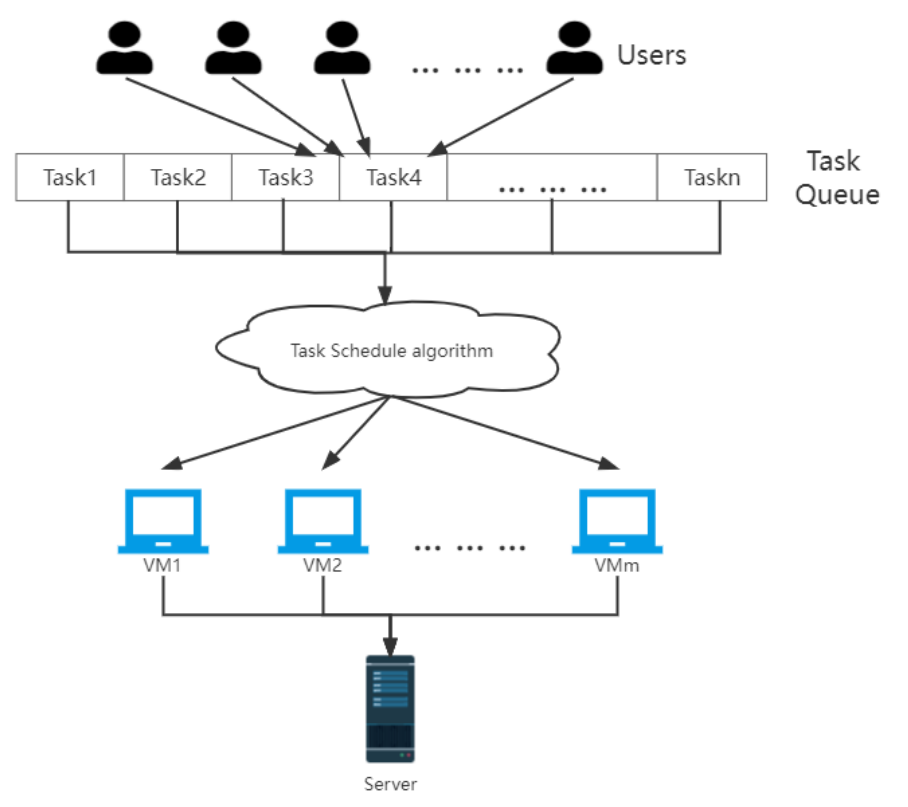
Figure 1. Cloud computing task scheduling